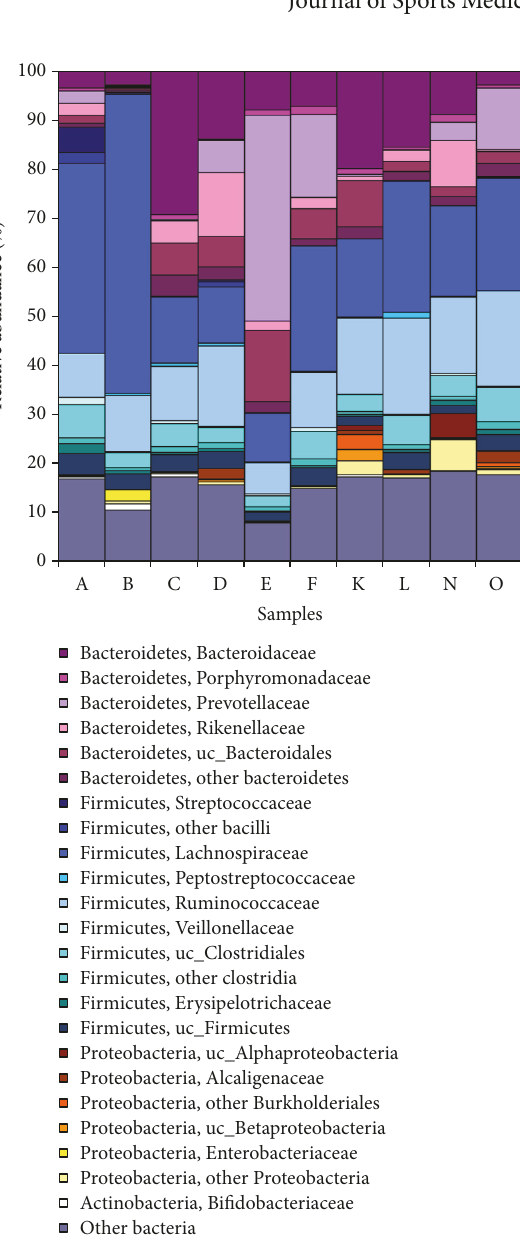
Figure 1: The relative abundance of the most common bacterial phyla in the active IM, analyzed in fecal samples of 10 healthy adults (A–O). Reprinted from Gosalbes et al.